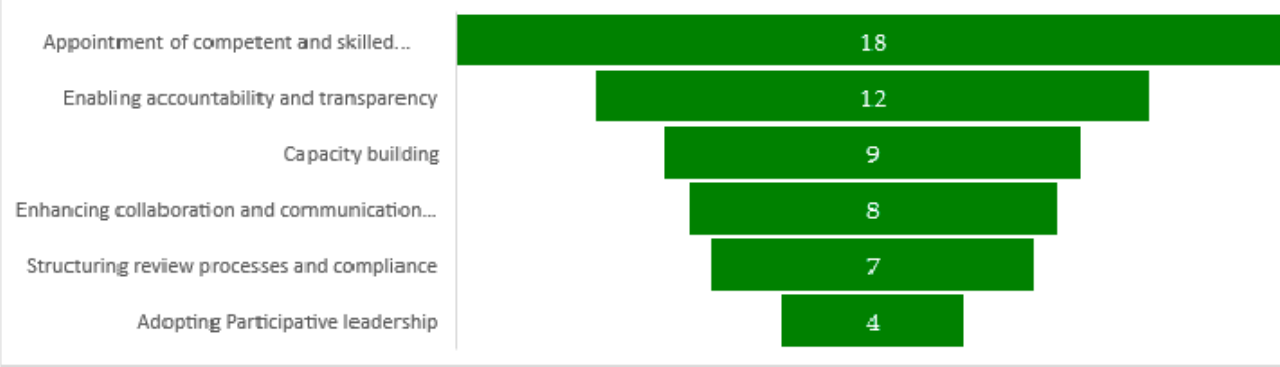
Figure 3. The relative impact of different strategic measures.